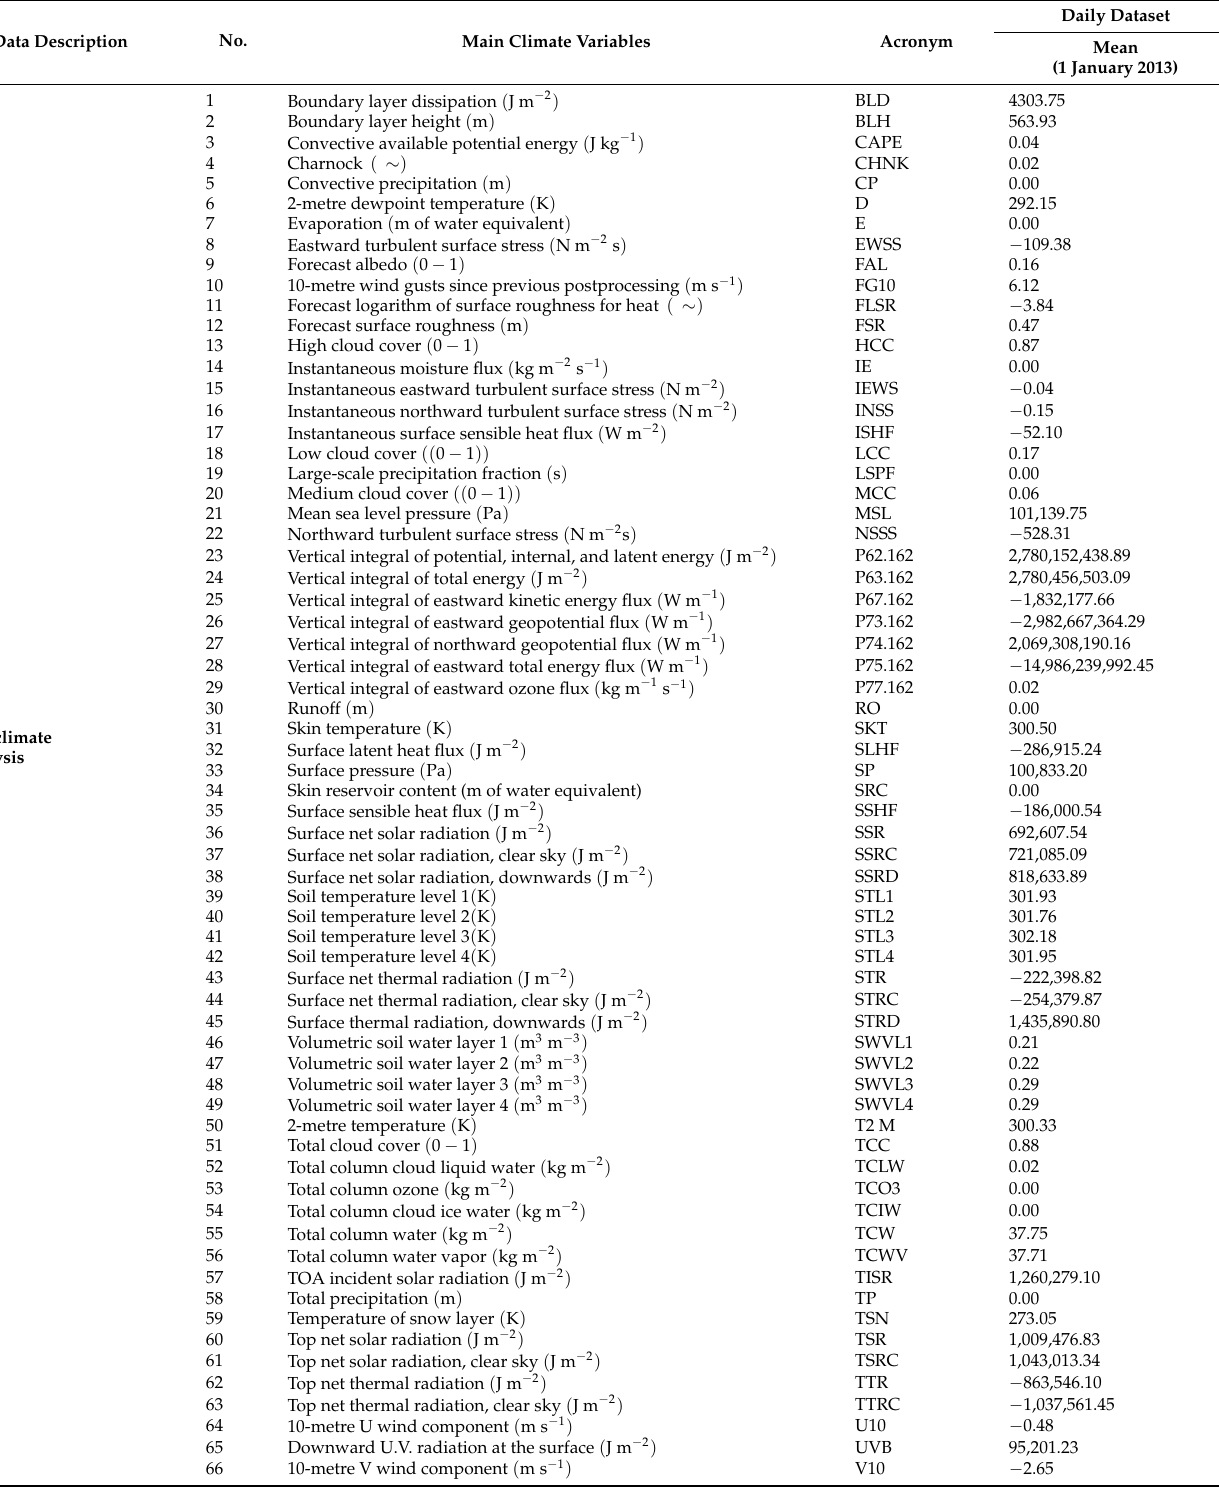
Table A1. Input climate variables from the ECMWF-ERA5 climate